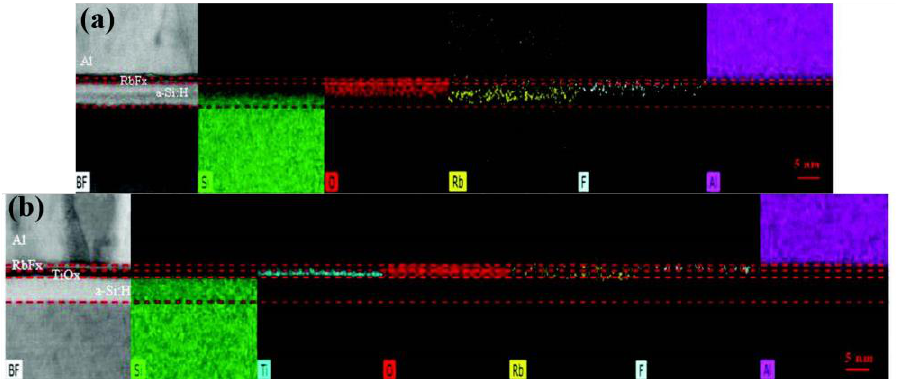
Figure 8. Cross − sectional energy dispersive X − ray spectroscopy (EDX) distributions without and with TiO x layer: ( a ) In the absence of TiO x , there is observable penetration of O, Rb, and F, which results in degraded passivation quality. ( b ) There is no elemental penetration in the condition of the TiO x interlayer [132].